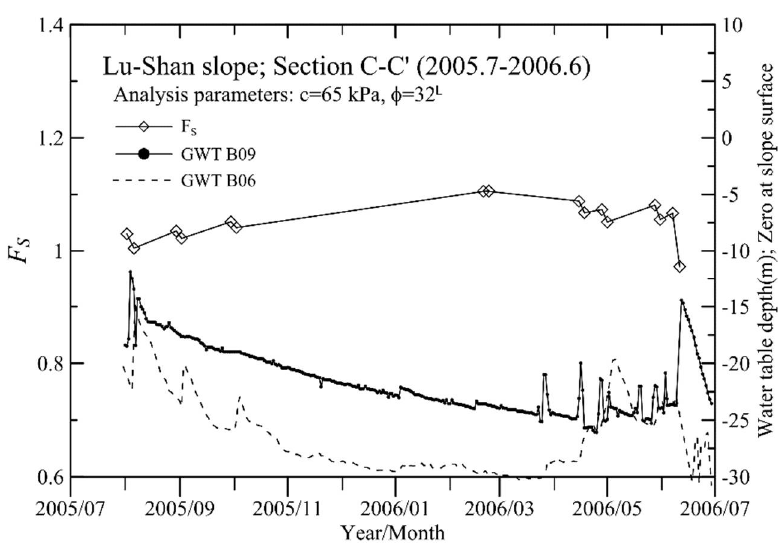
Figure 17. Comparison of recorded groundwater table heights and calculated safety factors for studied slope. Table 3. Events of intensive rainfall and measured slope displacements.